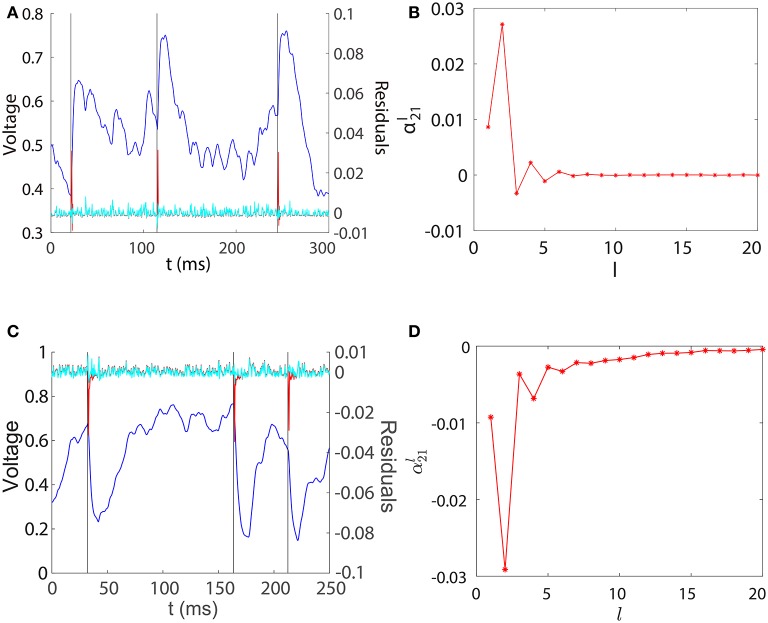
Regression components in STR. (A) Spikes of neuron 1 (black), subthreshold voltage trace of neuron 2 (blue), the filtered subthreshold voltage trace ΔVt(2) (red), and the regression residual ϵt(2) (cyan) are plotted for the two-neuron I&F network with a unidirectional excitatory connection from neuron 1 to neuron 2 for which s12 = 0, s21 = 0.08. (B)
α21l as a function of l obtained from the same network as in (A). (C,D) for the case of inhibitory connection. s12 = 0, s21 = −0.2. Note that for both excitatory and inhibitory couplings, we have M21=α21(2) (i.e., lij = 2), which attains the peak (absolute) value of α21l.